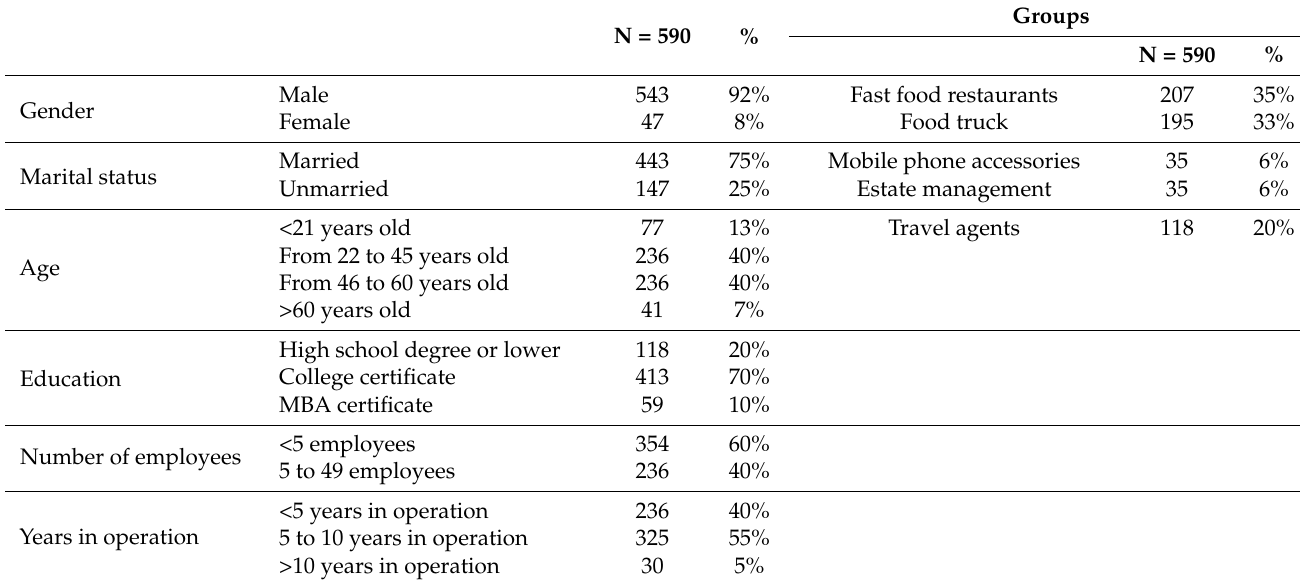
Table 3. Entrepreneurs’ demographics and business profiles.